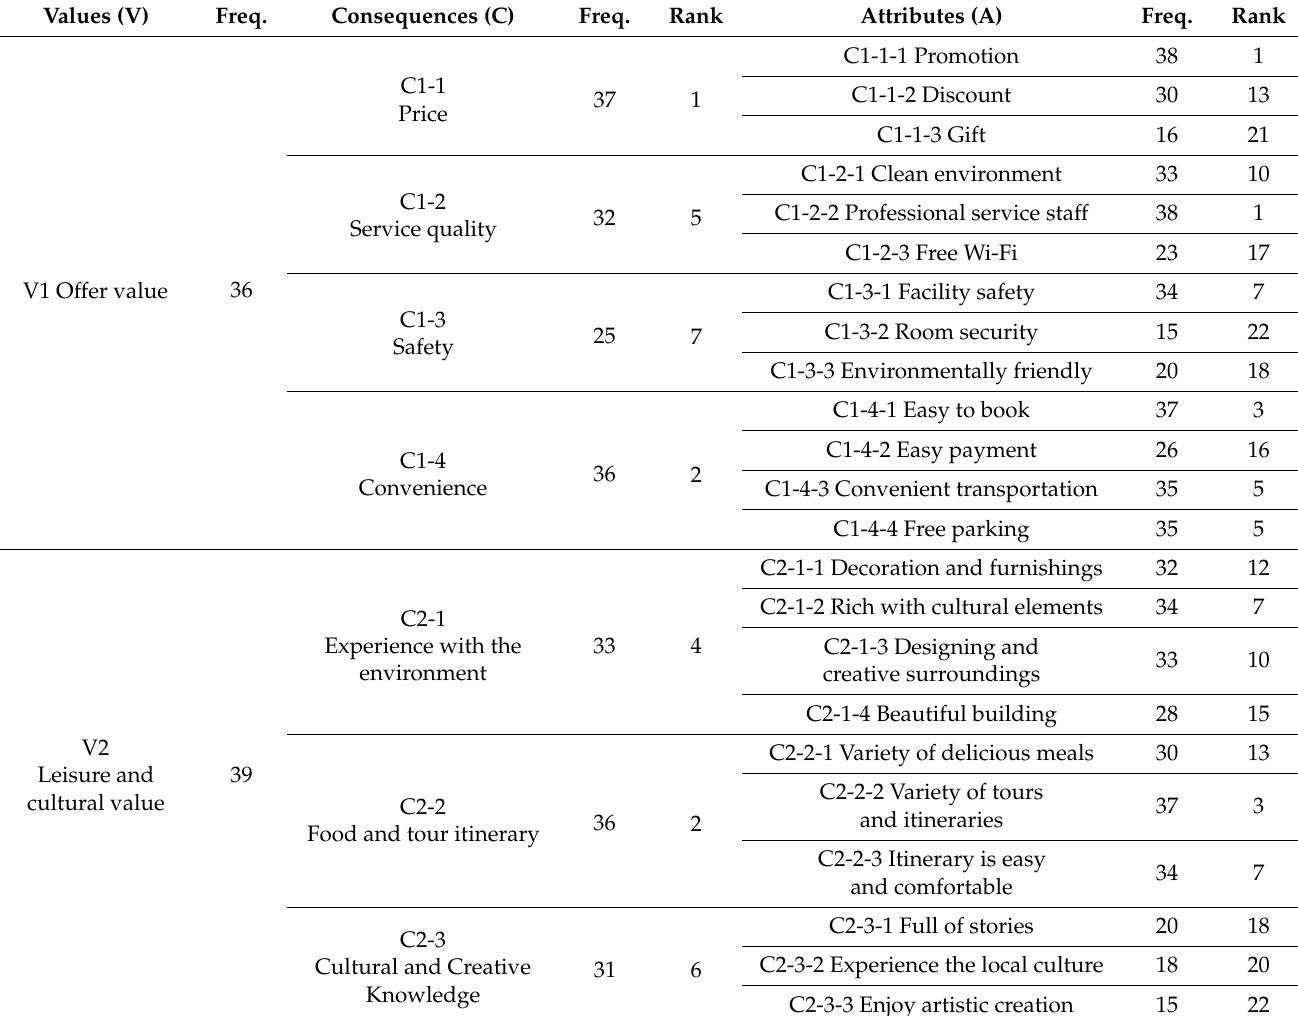
Table 1. Frequency of each attribute, consequence, and